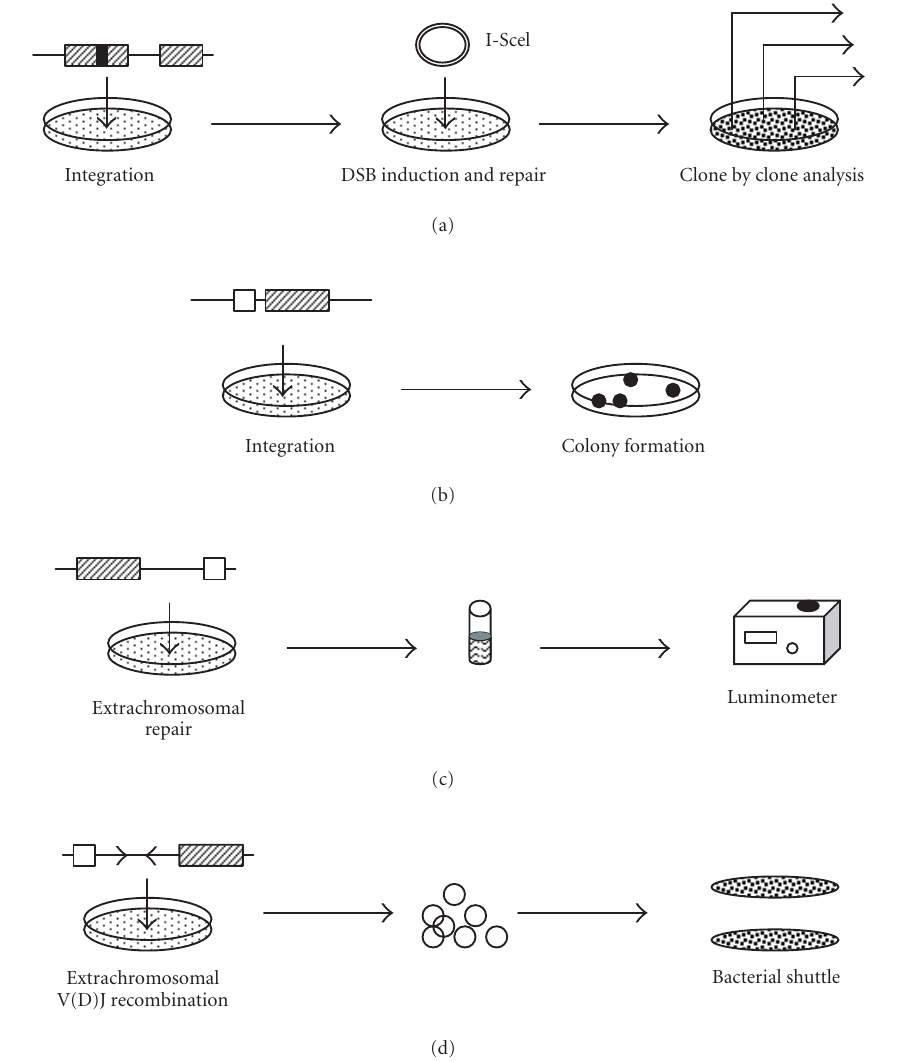
Figure 3. Illustration of the principles of measuring NHEJ with plasmid assays. (a) Physical analysis of chromosomal NHEJ. Analogous to Figure 1a, I-SceI breaks are generated in an integrated HR substrate, but cells are plated without selection antibiotic. Colonies are analyzed on a clone by clone basis for an NHEJ product using Southern blot and PCR. Alternatively, PCR of genomic DNA can be used for semiquantitative analysis of NHEJ [16]. (b) Random plasmid integration [29, 31]. The transfection frequency of a linearized reporter plasmid as a measure of NHEJ is scored by selecting for the intact resistance gene, for example, with puromycin. (c) Extrachromosomal rejoining assay [32]. A Luciferase expression plasmid is cleaved between the promoter and the reporter gene prior to the transient transfection. In the cell, Luciferase can only be expressed following NHEJ and re-circularization of the plasmid. Cell extracts are assayed for Luciferase activity. (d) Episomal V(D)J recombination [34]. Analogous to Figure 1d, recombination signal sequences flank a bacterial transcription stop signal upstream of a CAT reporter. The plasmid is cotransfected with Rag1/Rag2 expression vectors. The cleavage of the signal sequences followed by site-specific recombination removes the transcription stop signal, so that extracted plasmids can be assessed for CAT resistance in a bacterial shuttle vector